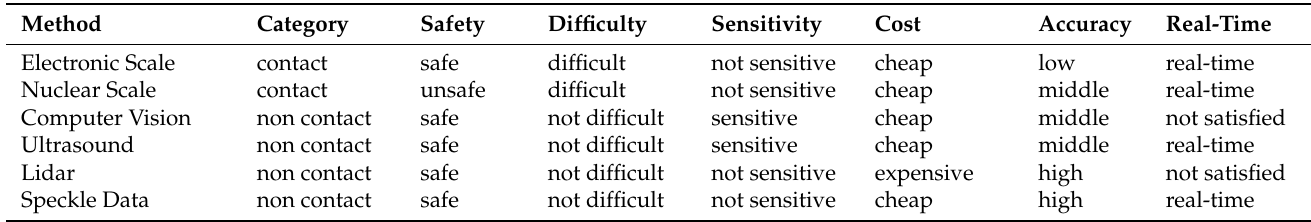
Table 3. Performance comparison of different